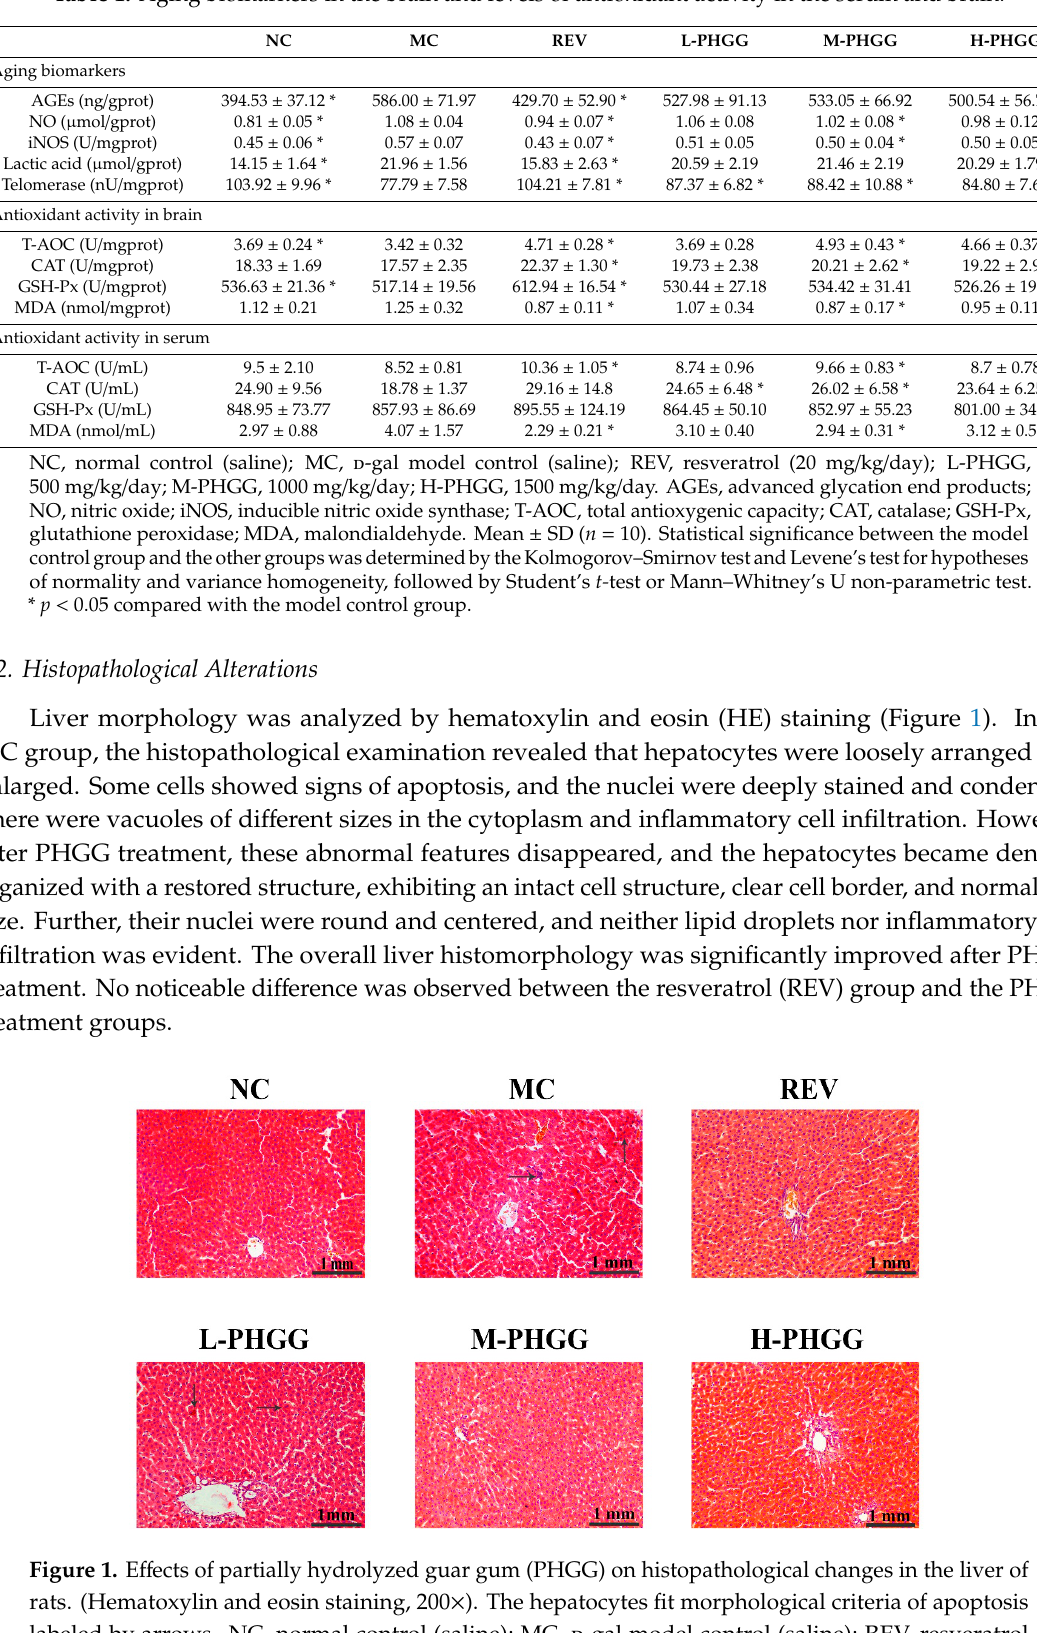
Table 1. Aging biomarkers in the brain and levels of antioxidant activity in the serum and brain.